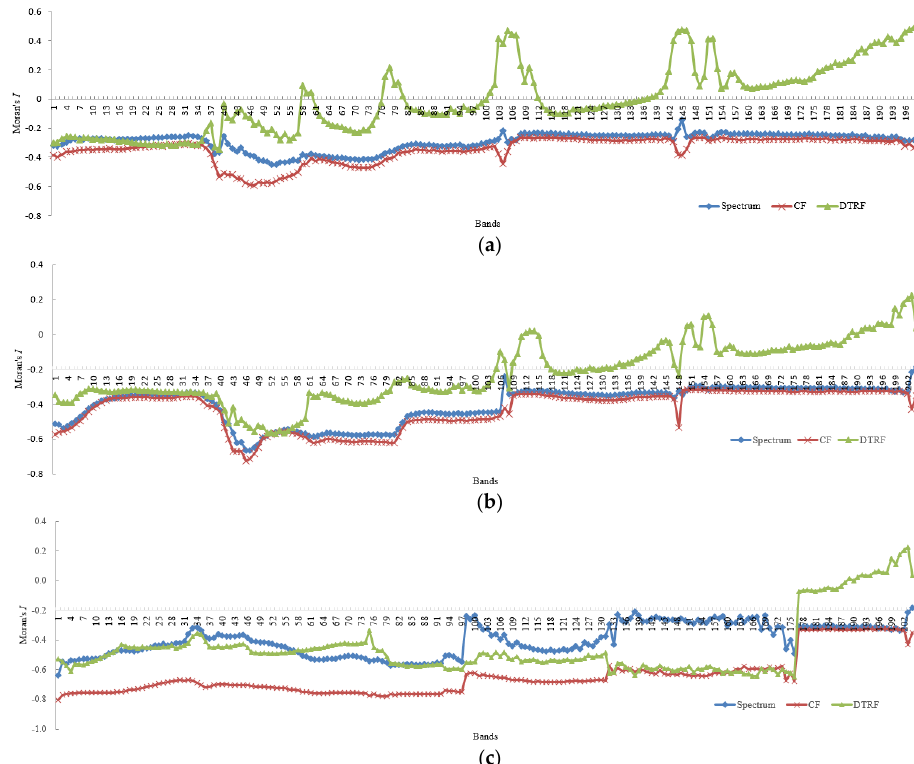
Figure 7. Average of Moran’s I for hyperspectral images (HSI) ( a ) Indian Pines ( b ) Salinas Valley ( c ) Kennedy Space